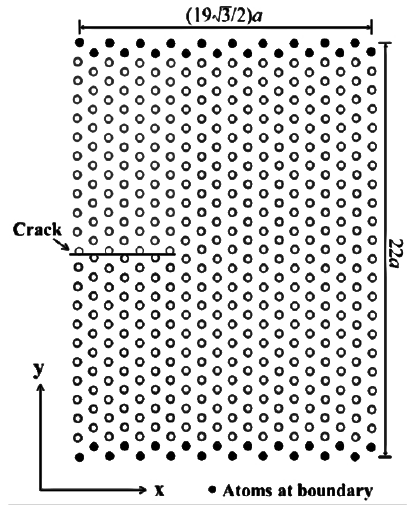
Figure 1. The two dimensional tensile model.